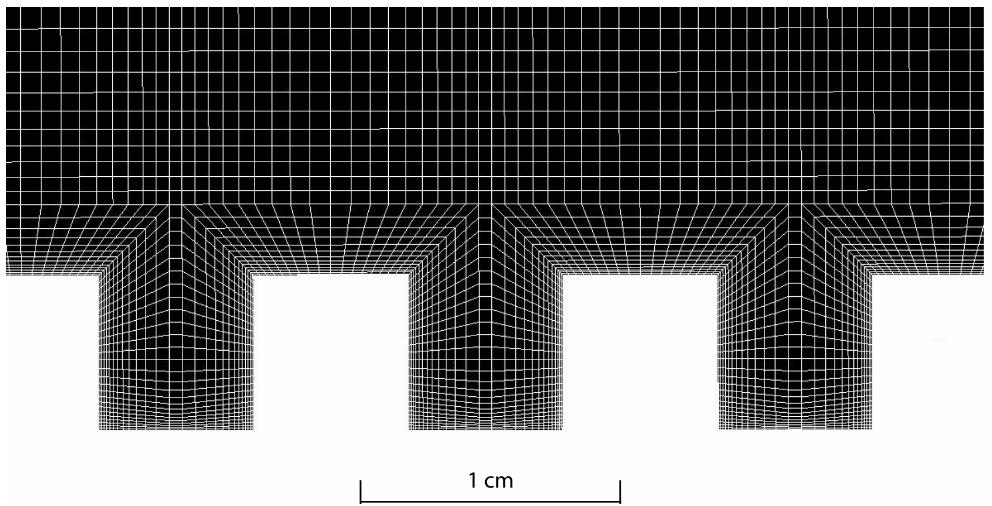
Figure 2. An elevation view of part of the mesh for Run 1, showing near-wall refinements and gradual growth rate of mesh